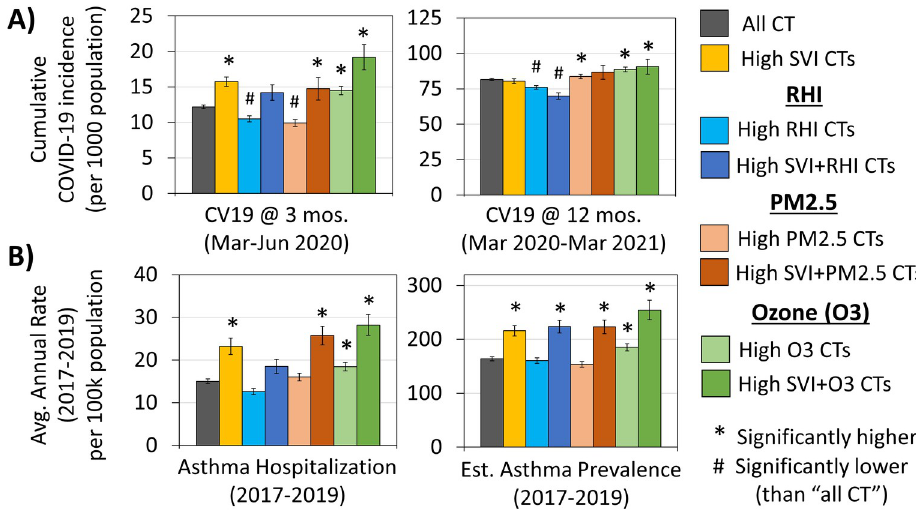
Fig 1. COVID-19 and asthma in areas with high social and/or environmental vulnerability. (A) High SVI was associated with higher average cumulative COVID-19 incidence rates early in the pandemic, whereas PM 2.5 was associated with higher rates later in the pandemic. Cumulative COVID-19 incidence was elevated in areas of high Ozone at all points during the pandemic. (B) Asthma hospitalization as well as estimated asthma prevalence followed a similar pattern with higher rates of both being associated with high SVI and high Ozone. Error bars indicate 95% confidence intervals; asterisks ( � ) indicate areas that are significantly higher than “All CTs” and pounds (#) indicate areas significantly lower than “All CTs” (p < 0.05;